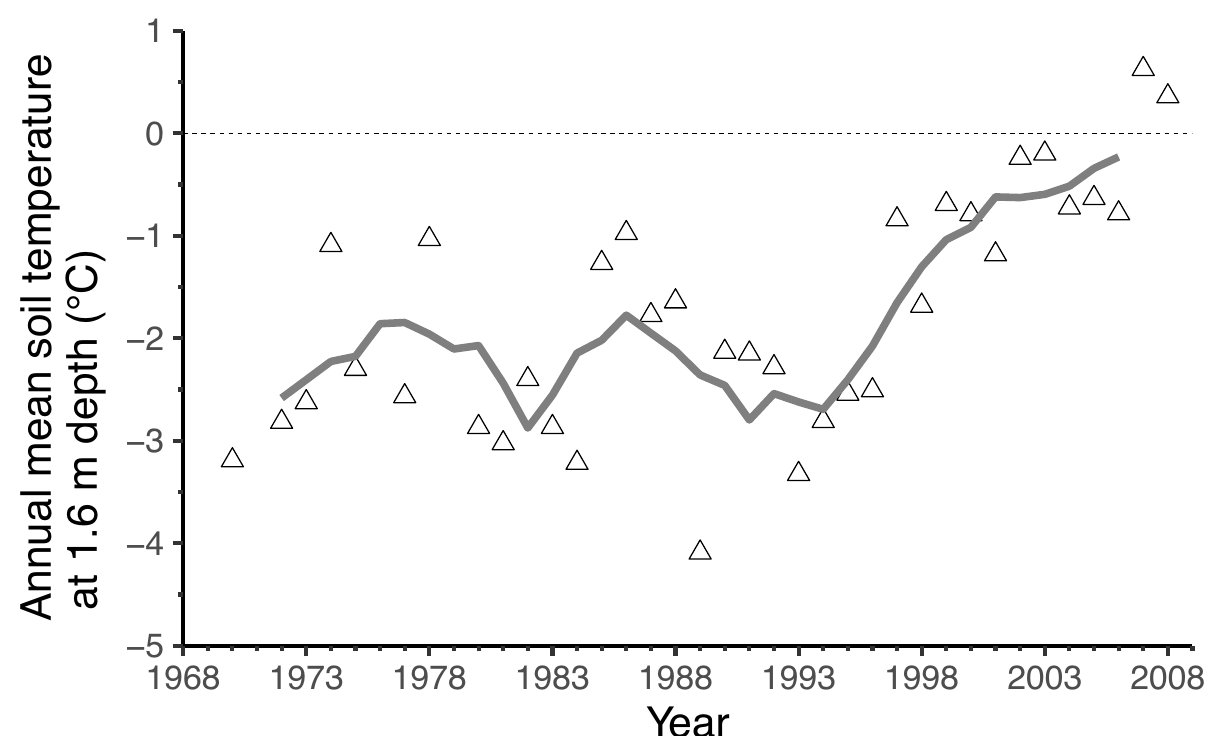
Figure 15. Temporal variation in observed annual mean soil temperature at site 25,206 from 1969 to 2008. Gray line denotes five years’ running